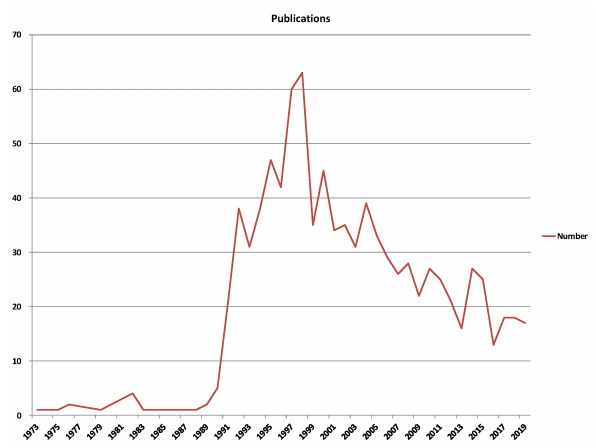
Fig. 2. The number of publications by year and the overall trend consistently kept gradually reducing from 1998 to